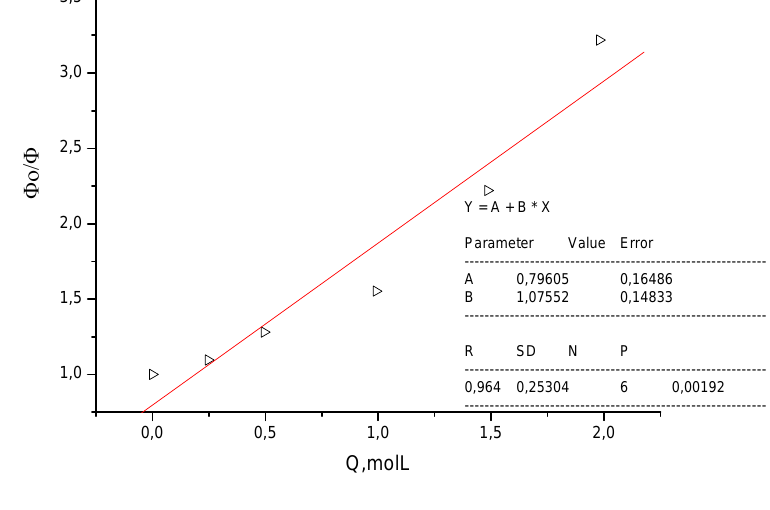
= 1.08 mol − 1 dm 3 ). SV